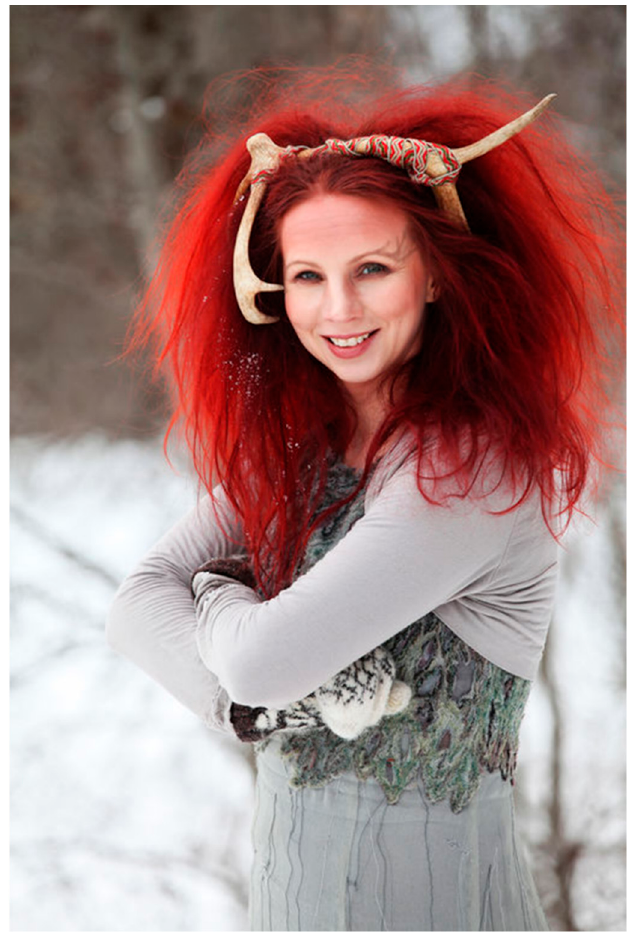
Figure 2. Artist Elin Kåven wearing reindeer antlers (Photo: Freddy Ludvik